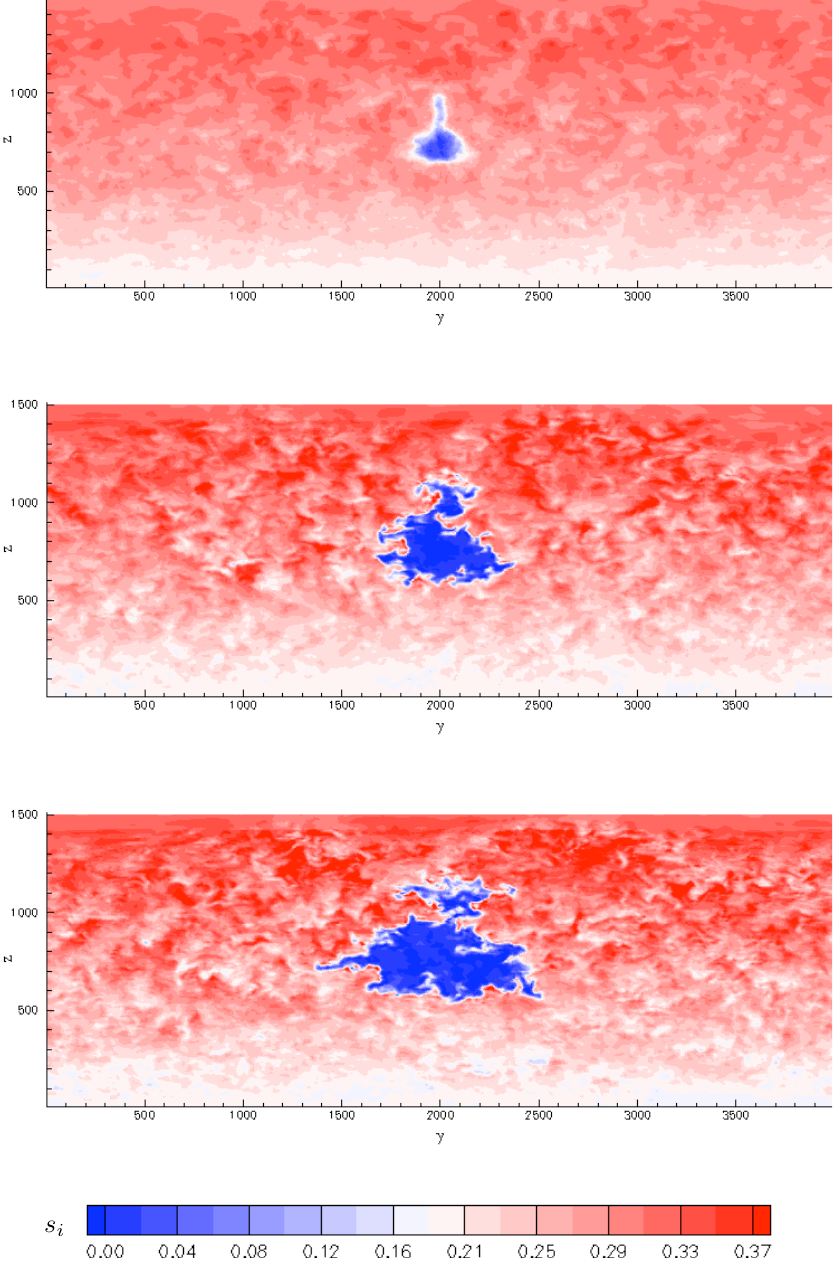
Fig. 16. Evolution of supersaturation s i during the late dissipation regime (run D 1). From top to bottom: t = 320s, 1120s and 2120s. Supersaturation fluctuations are driven by turbulent fluctuations (Eqs. 19-22) that spread the contrail mostly in the horizontal direction.